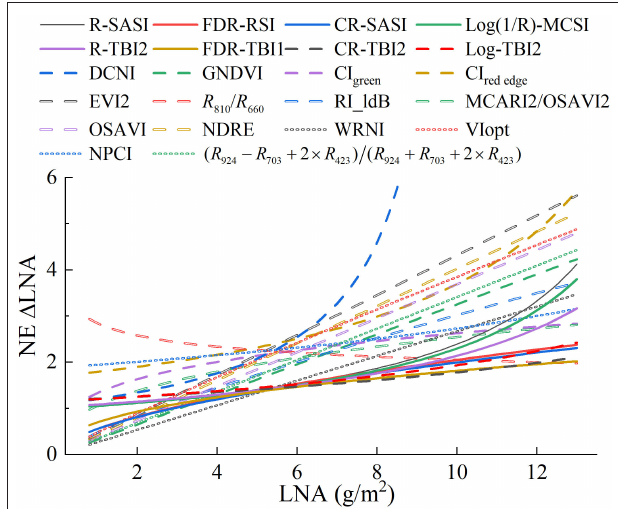
FIGURE 9 | Noise equivalent of leaf nitrogen accumulation (LNA) estimation by different spectral indices.